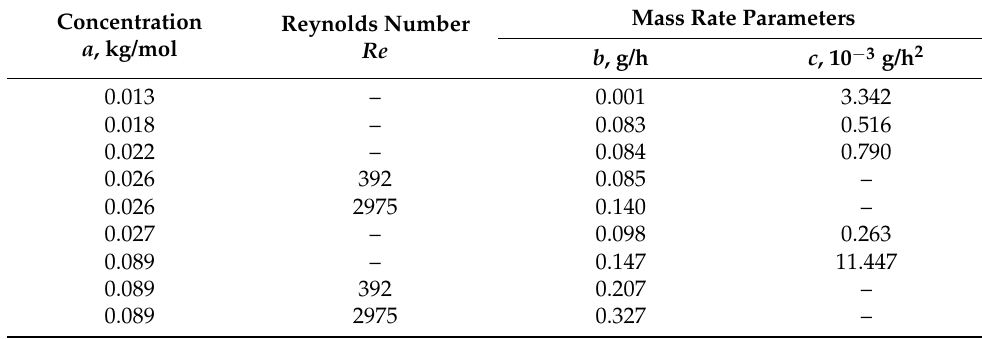
Table 1. Reaction rate constants for Cd deposition on the cathode.